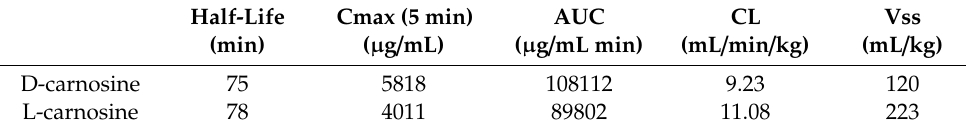
Table 1. Pharmacokinetic analysis of D- and L-carnosine in serum ( n = 4~5).